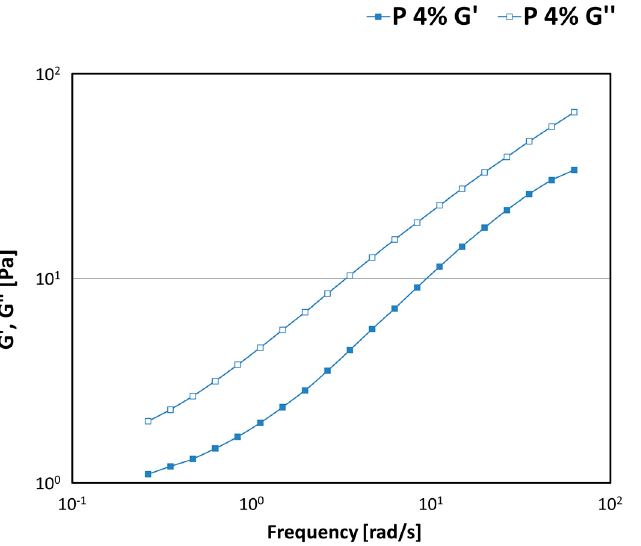
Figure 9. Storage (G ′ ) and loss (G ″ ) moduli trend as a function of the frequency for the sample prepared with P at 4% w/w.